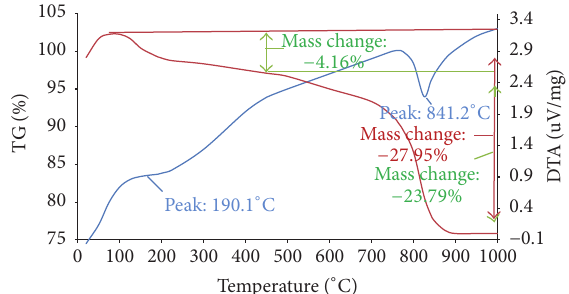
Figure 14: ATG and ATD powder of concrete with binary